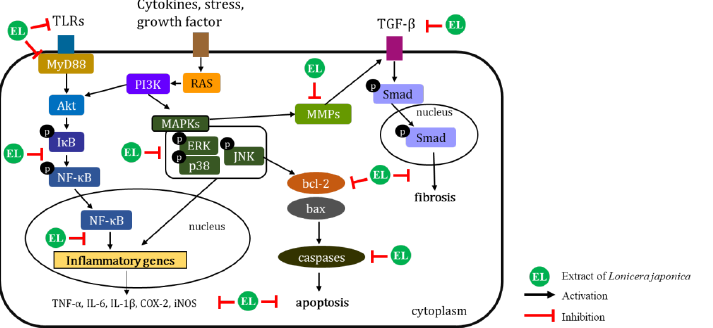
Figure 10. A schematic illustration shows the protective effect of extract of Lonicera japonica in particulate-matter (PM) 2.5 -induced pulmonary dysfunction in BALB/c mice via regulation of the TGF- β/Smad/MMP signaling pathway.